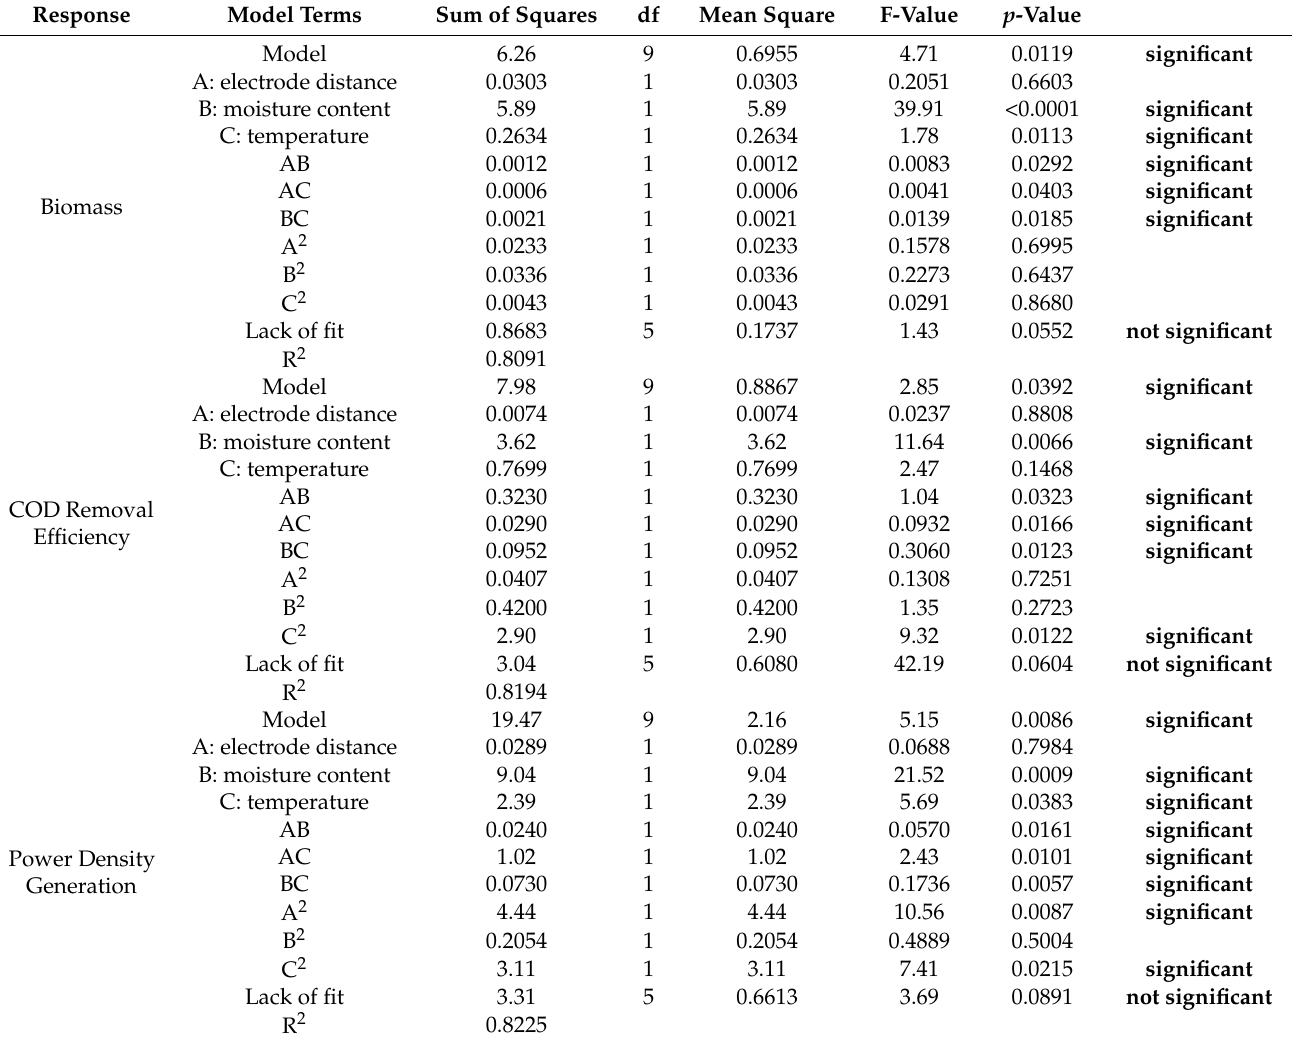
Table 3. ANOVA analyses ofbiomass, COD removal efficiency, and power density